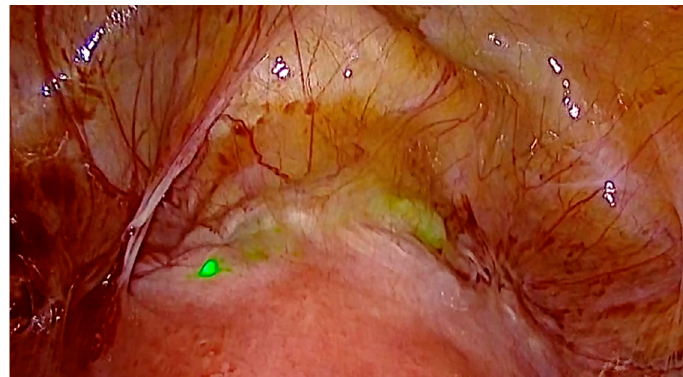
Figure 1. Laparoscopic fluorescence-guided view of uterine niche after intrauterine application of indocyanine green solution.